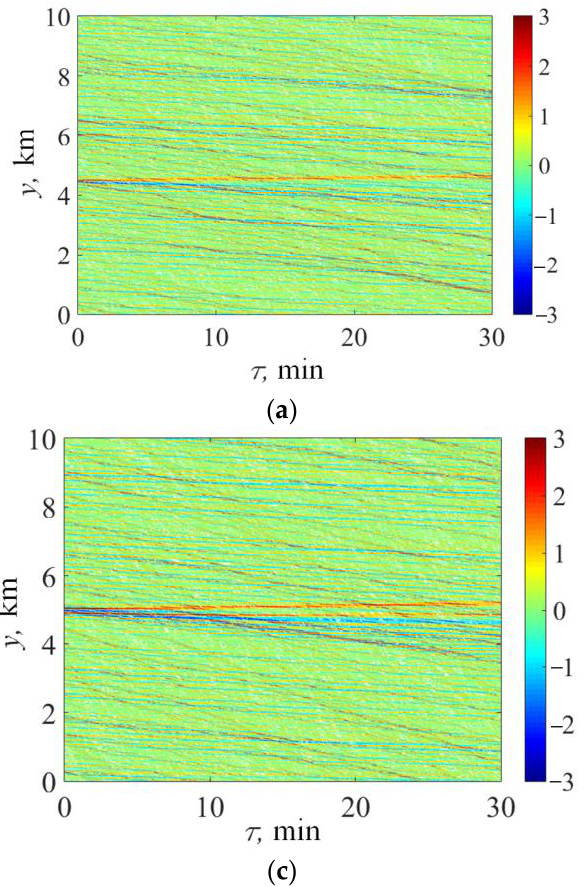
Figure 11. Spatiotemporal diagram: ( a ) sign-variable wave; ( b ) “two sisters”; and ( c ) “three sisters”.